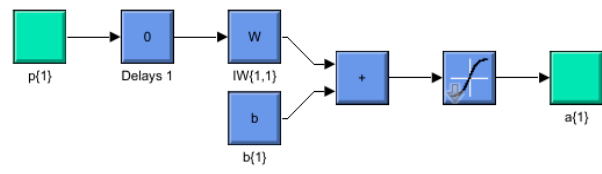
Figure 14. Subsystem of Layer 1 of an ANN.